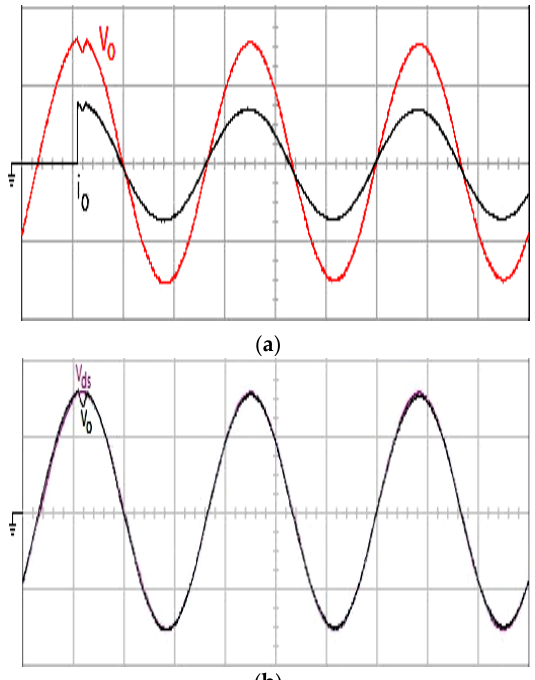
Figure 6. ( a ) Experimental waveforms of the output voltage and output current under step load change for the proposed control technique (100 V/div; 20 A/div; 5 ms/div); ( b ) Trajectories of output voltage and reference sine wave (100 V/div; 5 ms/div).